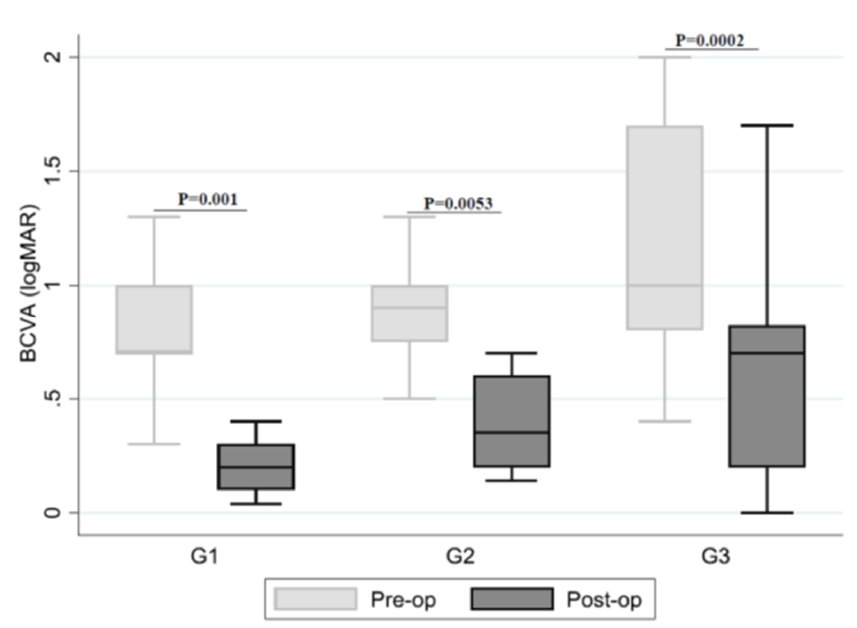
Figure 1. Relationship between pre- and post-op logMAR and groups (median, IQR, range). Legend: BCVA pre-op = best corrected visual acuity before surgery; BCVA post-op = best corrected visual acuity after surgery; logMAR = Logarithm of the Minimum Angle of Resolution; Statistical analysis was performed using the Wilcoxon Signed Rank Test.